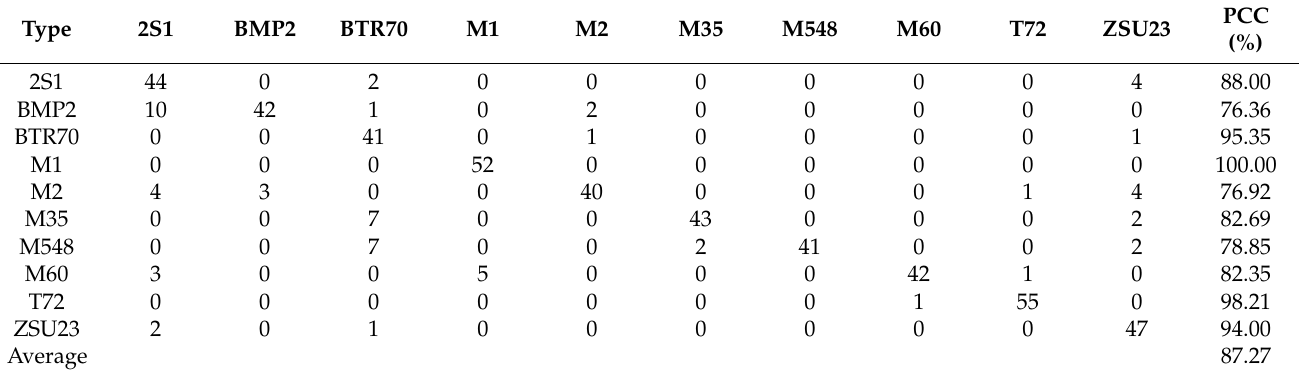
Table 3. Recognition results obtained using the proposed method within 10 target classification tests (test image: real 16 ◦ ; template image: synthetic 16 ◦ /17 ◦